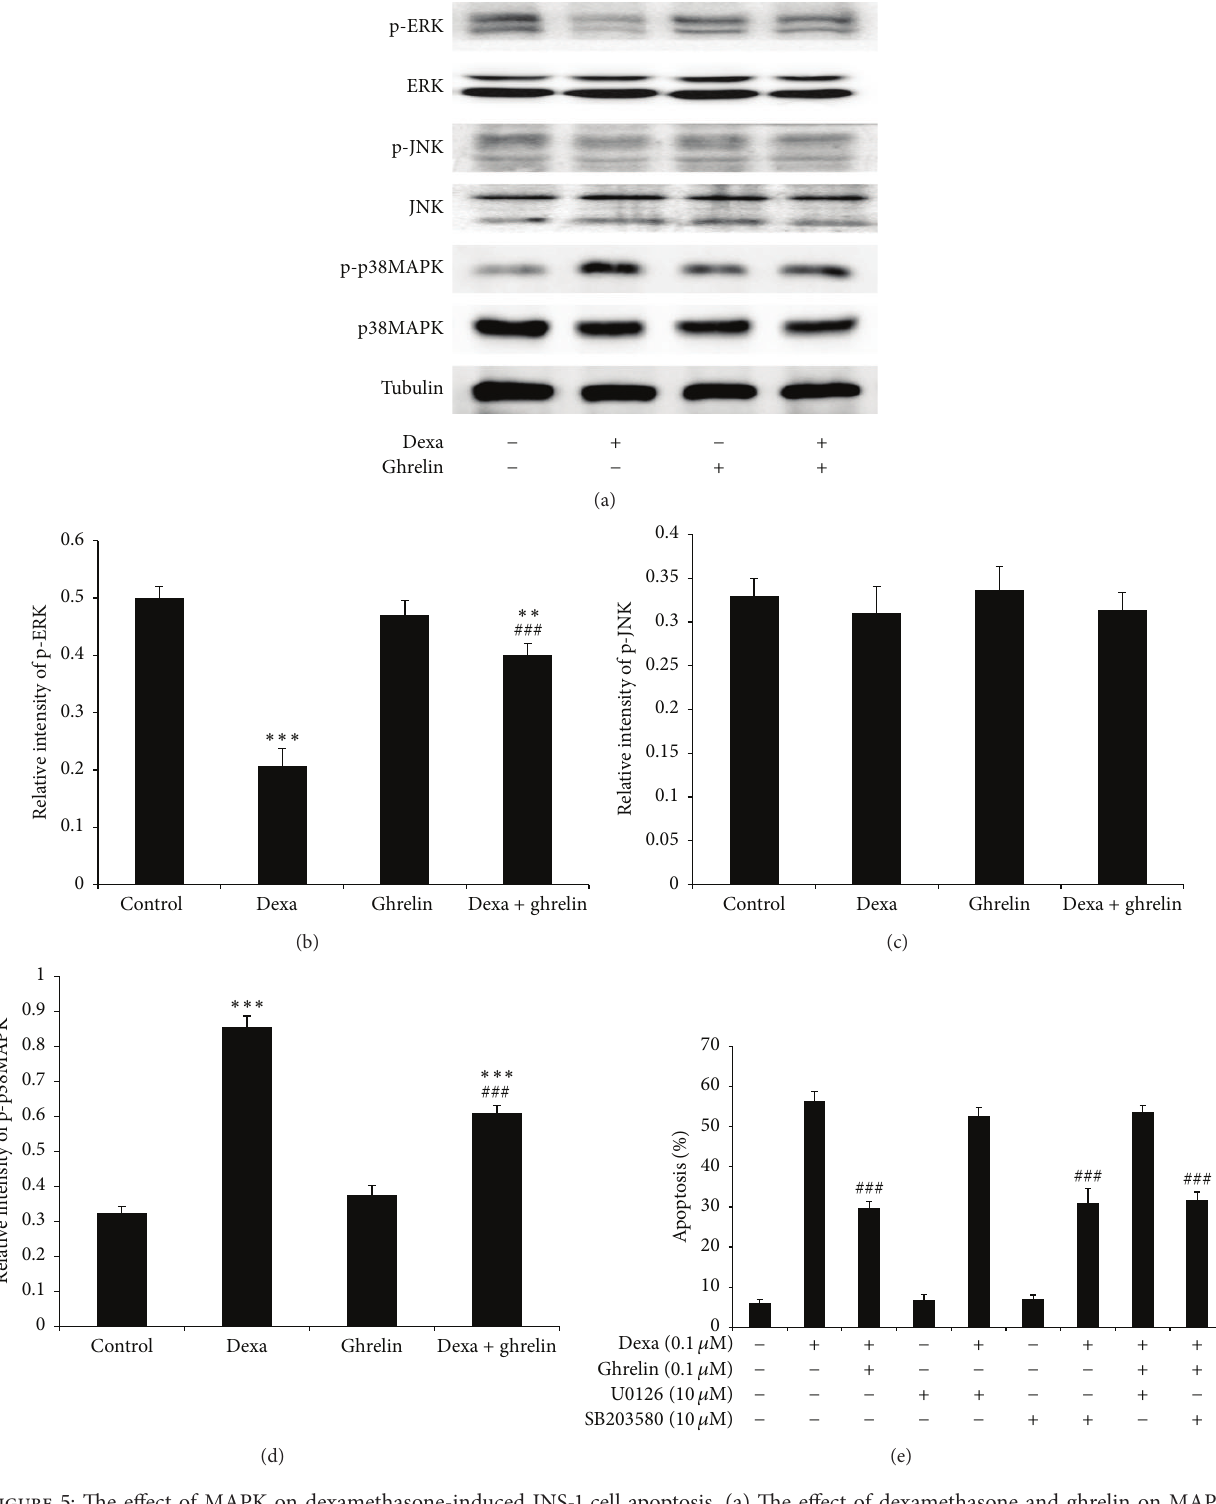
Figure 5: The effect of MAPK on dexamethasone-induced INS-1 cell apoptosis. (a) The effect of dexamethasone and ghrelin on MAPK expression in INS-1 cells. The expression of phospho-MAPK and MAPK in treated INS-1 cells was detected by western blot analysis. (b, c, d) Graphs indicate the quantitative analyses of pMAPK and MAPK. (e) The effect of ERK and p38MAPK inhibitors on INS-1 cell